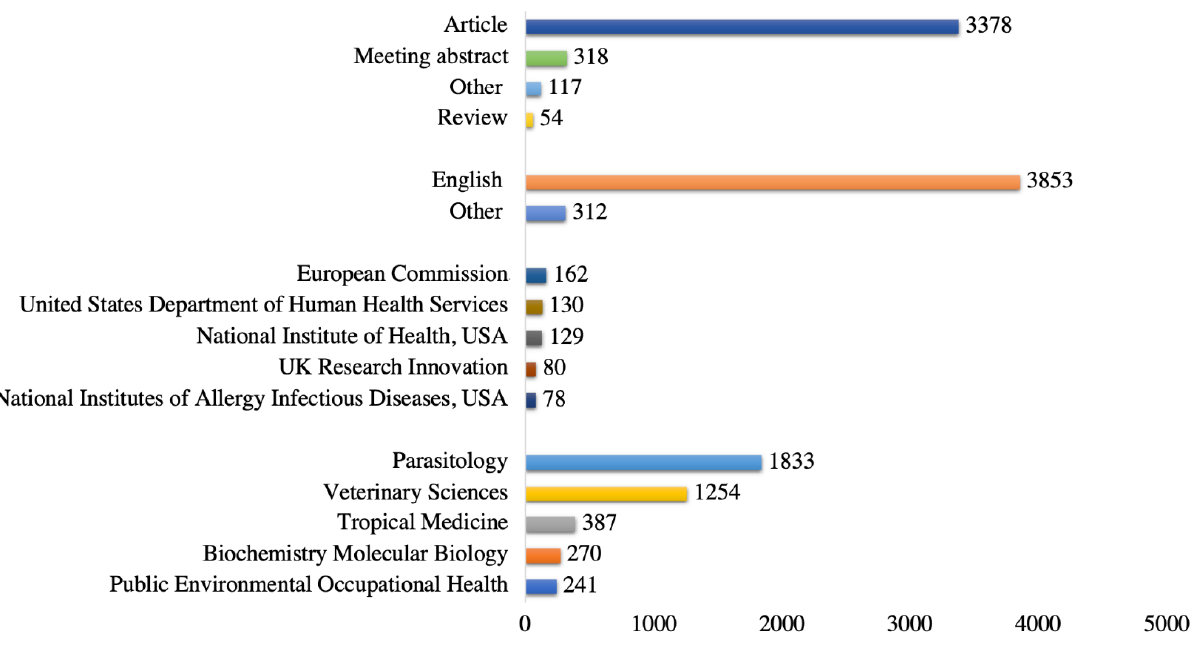
Figure 3. ( A ) Top five authors, ( B ) top five journals, ( C ) top five institutions, ( D ) top five countries in fascioliasis research. 3.4. Top Ten Most-Cited Papers in Fascioliasis The most- cited document in fascioliasis research was “Fascioliasis and other plant - borne trematode zoonoses” (Mas -Coma et al., 2005b) with 521 citations. Among the top ten most-cited documents, there were seven articles, two reviews, and one note. Table 1 shows the full details.